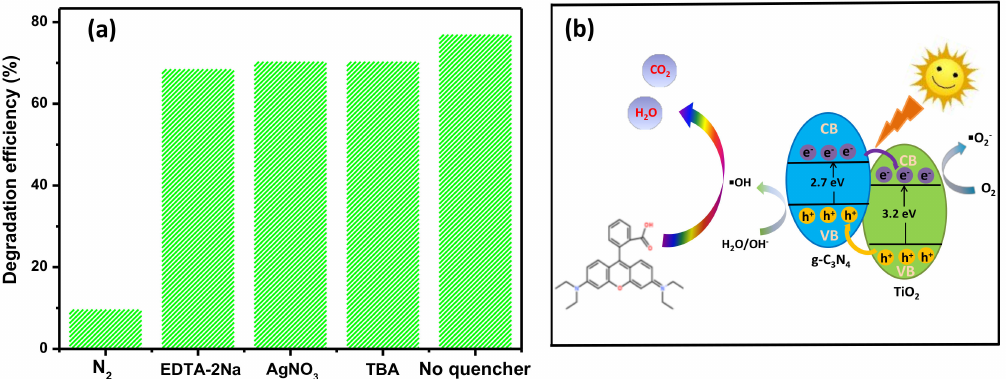
Figure 9. ( a ) Effects on photocatalytic performance by adding different kinds of scavengers; ( b ) Schematic illustration for the separation and recombination process of photogenerated carriers between TiO 2 and g-C 3 N 4 under visible light